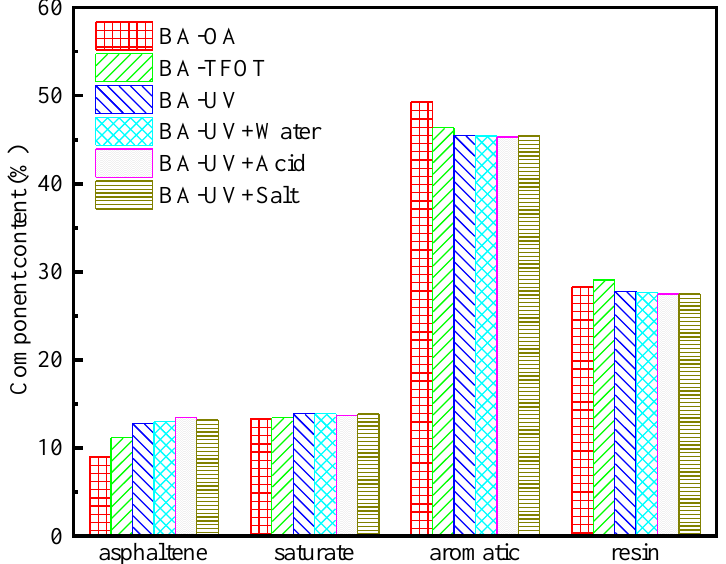
Figure 6. Four components of base asphalt after UV aging under different environmental conditions. Note: BA-OA is base asphalt-original asphalt.